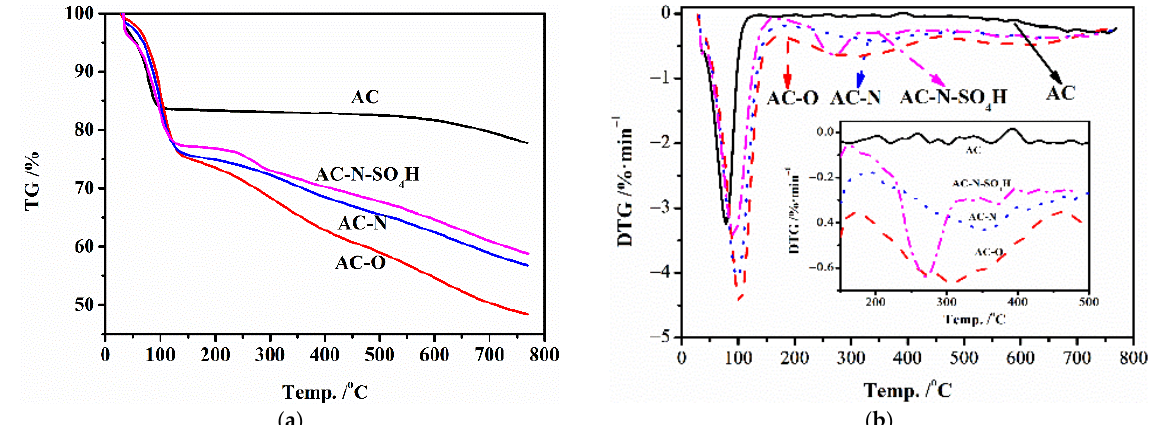
Figure 6. TG and DTG performance of AC-N-SO 4 H and its precursors. ( a ) TG; ( b ) DTG.